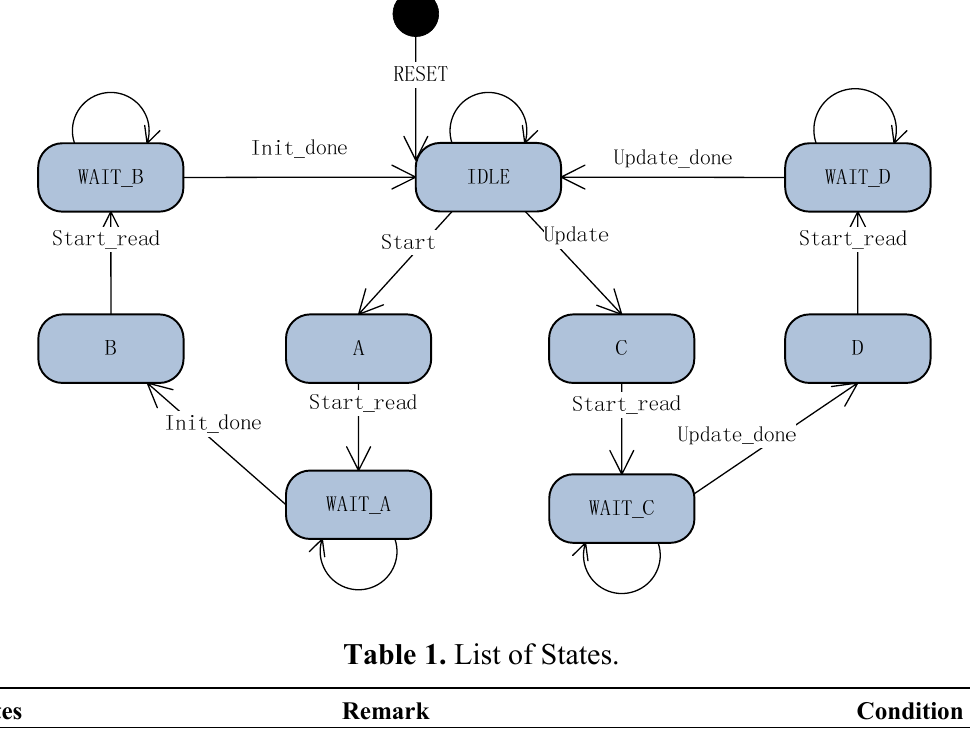
Figure 8. Finite State Machine of the Line Buffer Management.